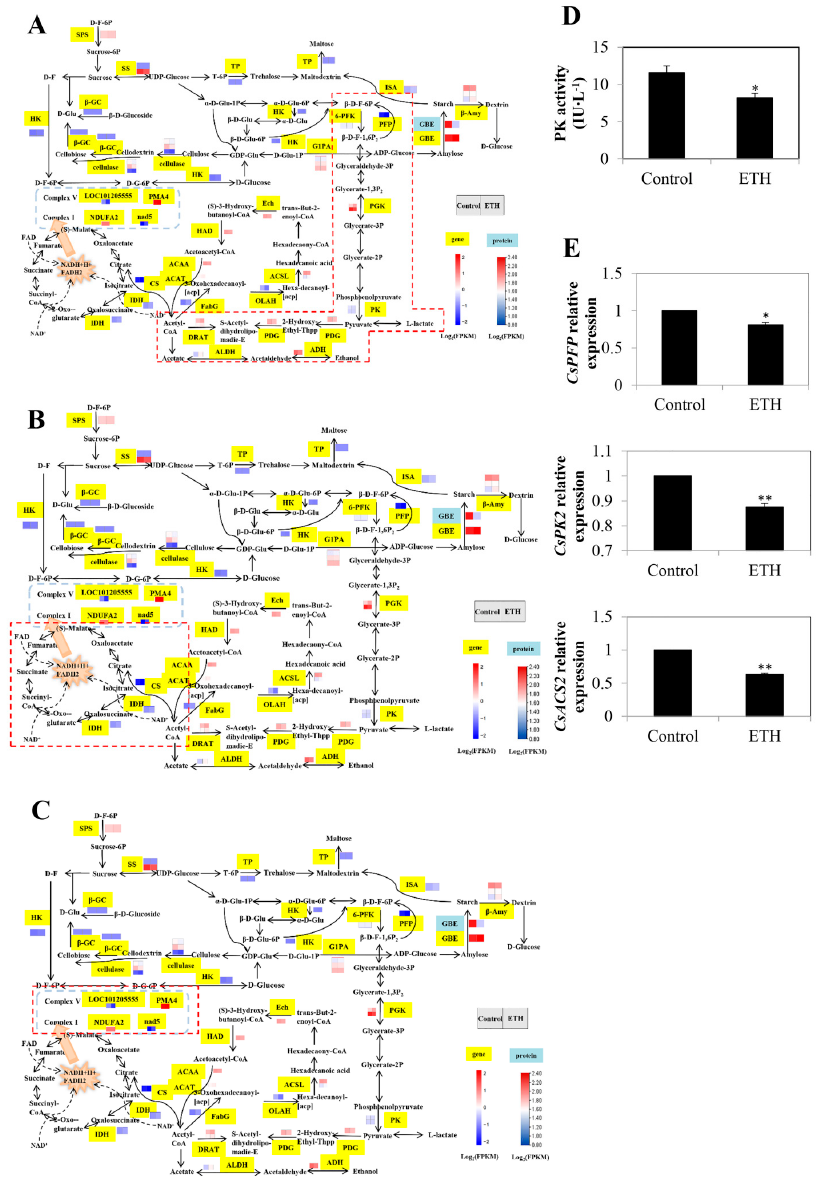
Figure 3. Identification and validation of key DEGs in glycolysis/gluconeogenesis, citrate cycle (TCA cycle) and oxidative phosphorylation during adventitious root development in cucumber. ( A ) Expression patterns of genes for glycolysis/gluconeogenesis during adventitious root development in cucumber. ( B ) Expression patterns of genes for TCA cycle in carbon metabolism during adventitious root development in cucumber. ( C ) Expression patterns of genes for oxidative phosphorylation in carbon metabolism during adventitious root development in cucumber. Annotations of genes and proteins are available in Supplementary Table S6. Black characters with yellow background are genes. The two squares under the names of genes or proteins indicate the abundance change of the control and ETH. A red square means up-regulation, whereas a blue square means down-regulation. The red dotted box represents the different pathways involved in carbon metabolism. ( D ) The activity of PK enzyme during adventitious root development in cucumber. ( E ) Quantitative real-time PCR analysis of the expression profiles of 6 genes related to glycolysis/gluconeogenesis, TCA cycle and oxidative phosphorylation during adventitious root development in cucumber. Asterisk (*) and double asterisk (**) indicate the significance at p < 0.05 and p < 0.01, respectively. The bar represents the value of standard error. Values represent the mean ± SE of three replicates. Each experiment was repeated three times